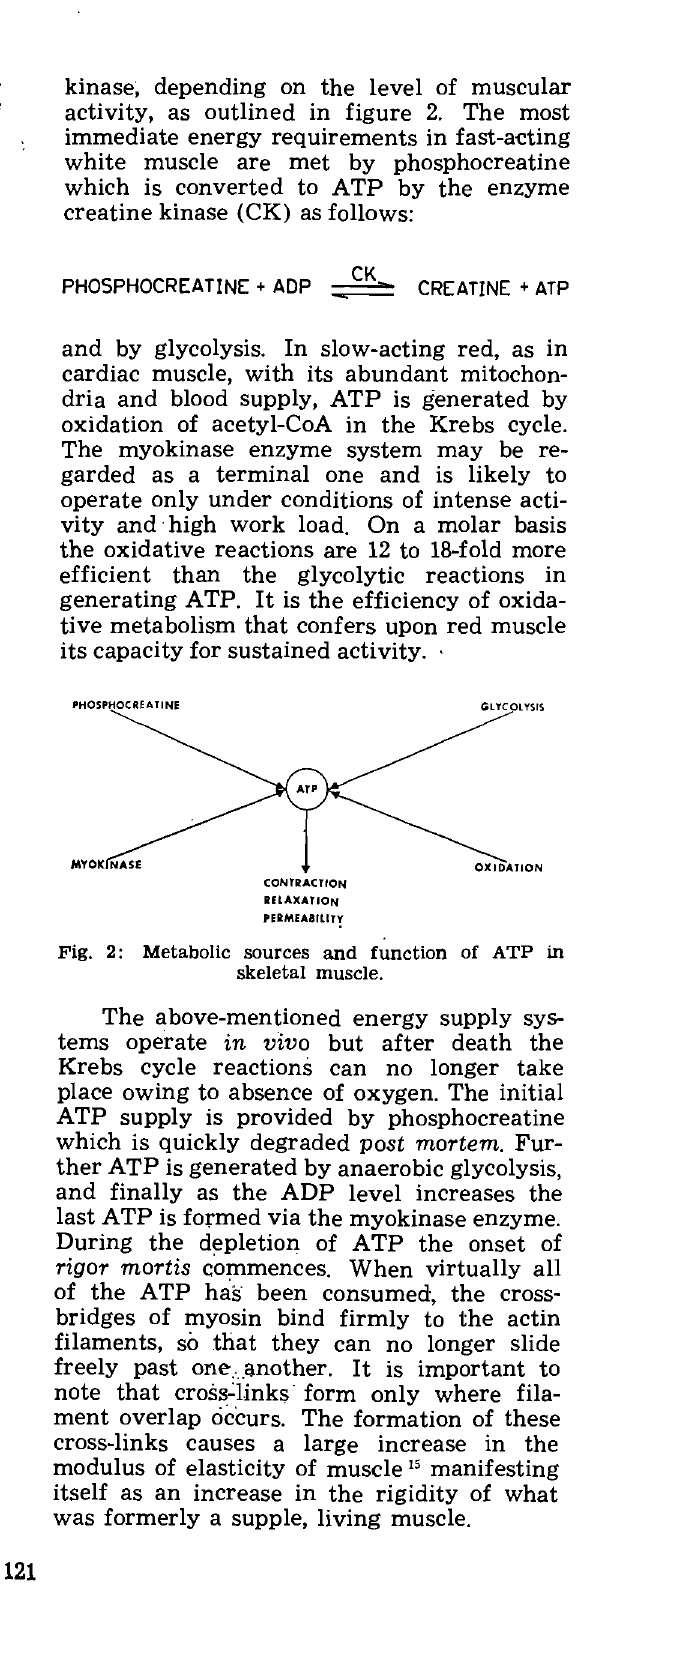
Fig. 2: Metabolic sources and function of A TP in skeletal muscle. The above-mentioned energy supply